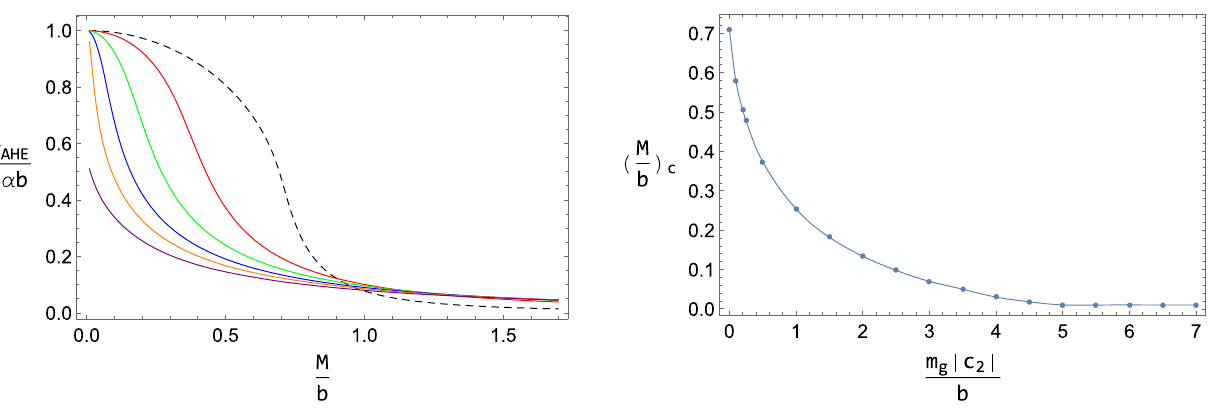
Fig. 4 The critical point as a function of graviton mass m g | c 2 | / b at T / b = 0 . 03 Table 1 The instability condition for scalar field perturbations T / b = 0 T / b = 0 . 03 m g | c 2 | / b 1 5 .